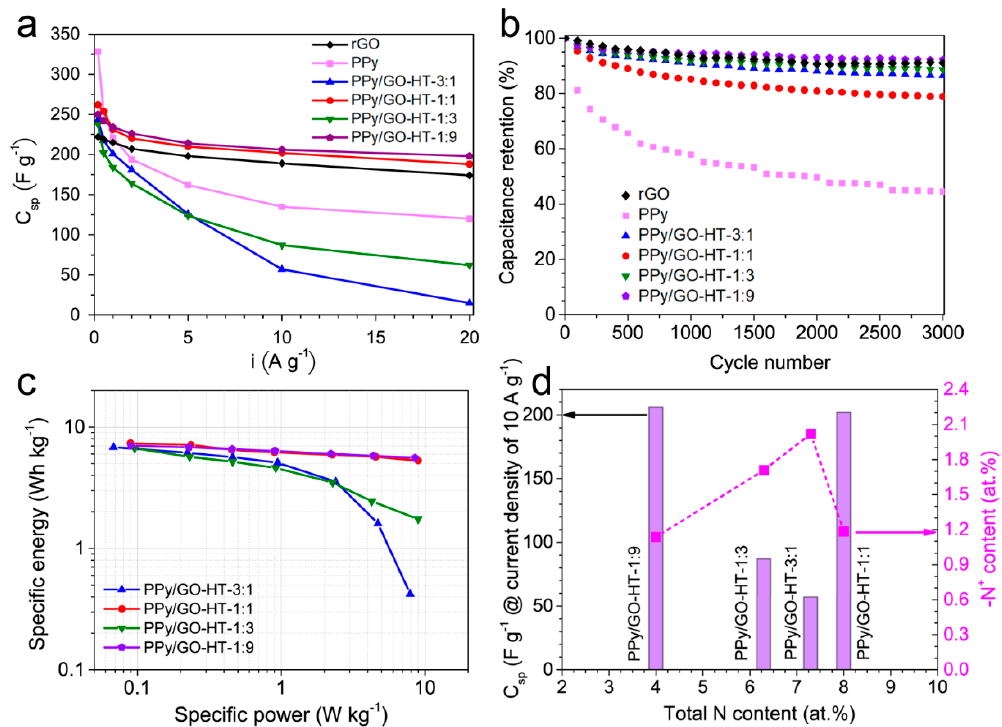
Figure 6. ( a ) Specific capacitance versus discharge current density for rGO, PPy and the PPy / GO-HT hybrids; ( b ) Electrode cycling stability at a current density of 2 A g − 1 for the PPy / GO-HT hybrids and their precursors; ( c ) Ragone plot of the specific energy density versus the specific power density of the PPy / GO-HT hybrids; ( d ) Relationship between the chemical composition and specific capacitance of the hybrid materials with di ff erent component mass ratios at a current density of 10 A g − 1 .